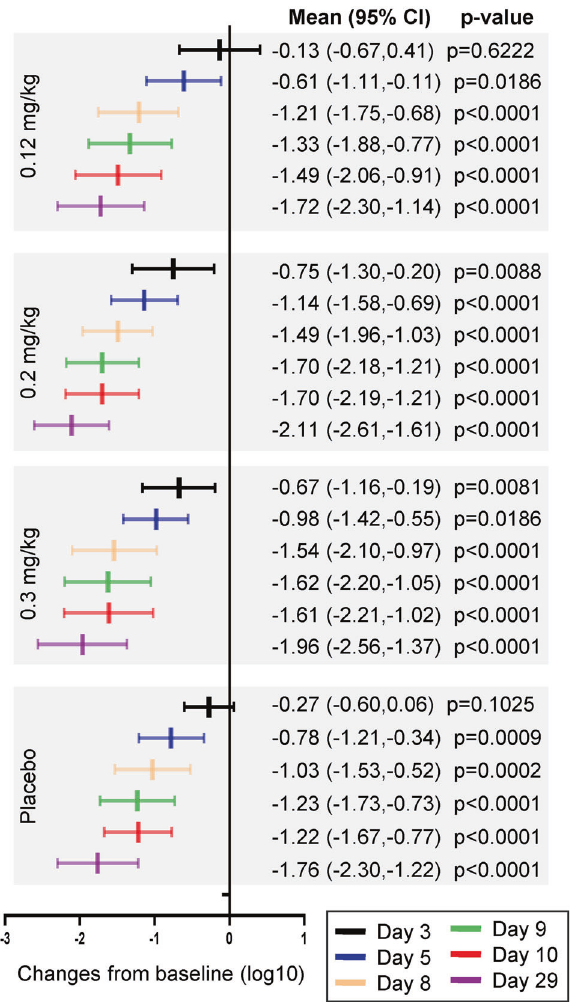
Fig. 2 Forest plot of viral load changes from baseline (log10). The paired t-test was used to compare the viral load at each time point with baseline in each group